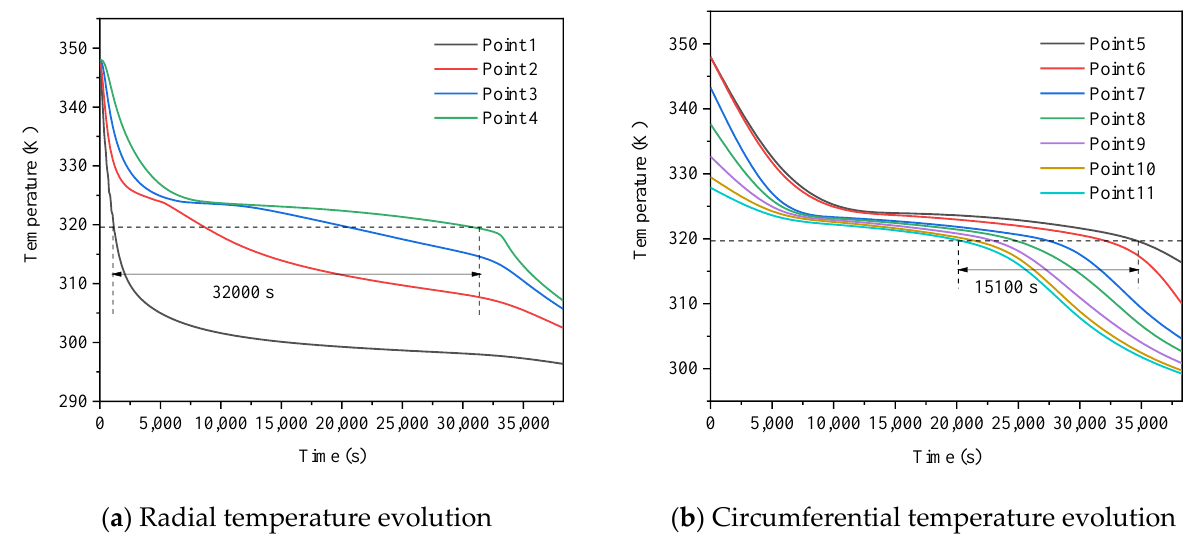
Figure 9. Evaluation of thermal penetration and thermal uniformity for solidification.